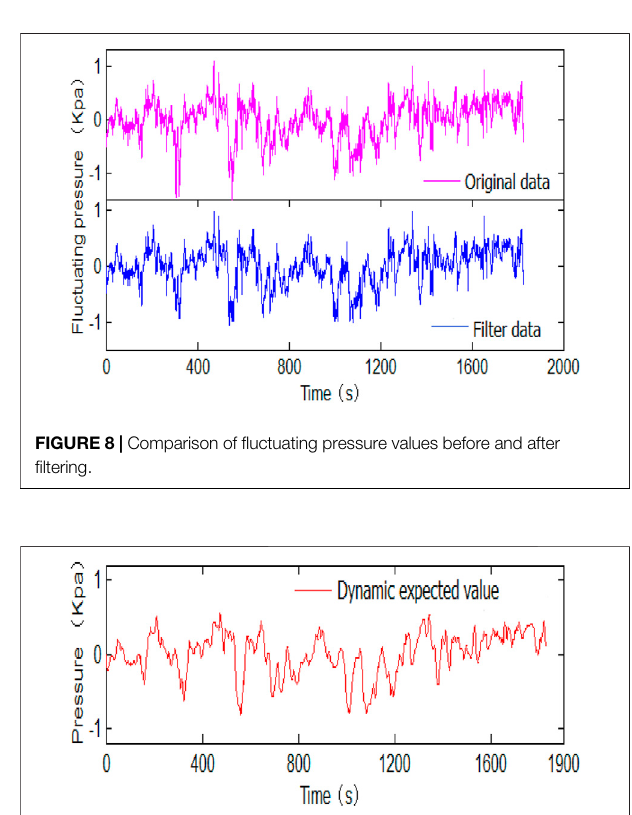
FIGURE 9 | Dynamic expectation curve of fl uctuating